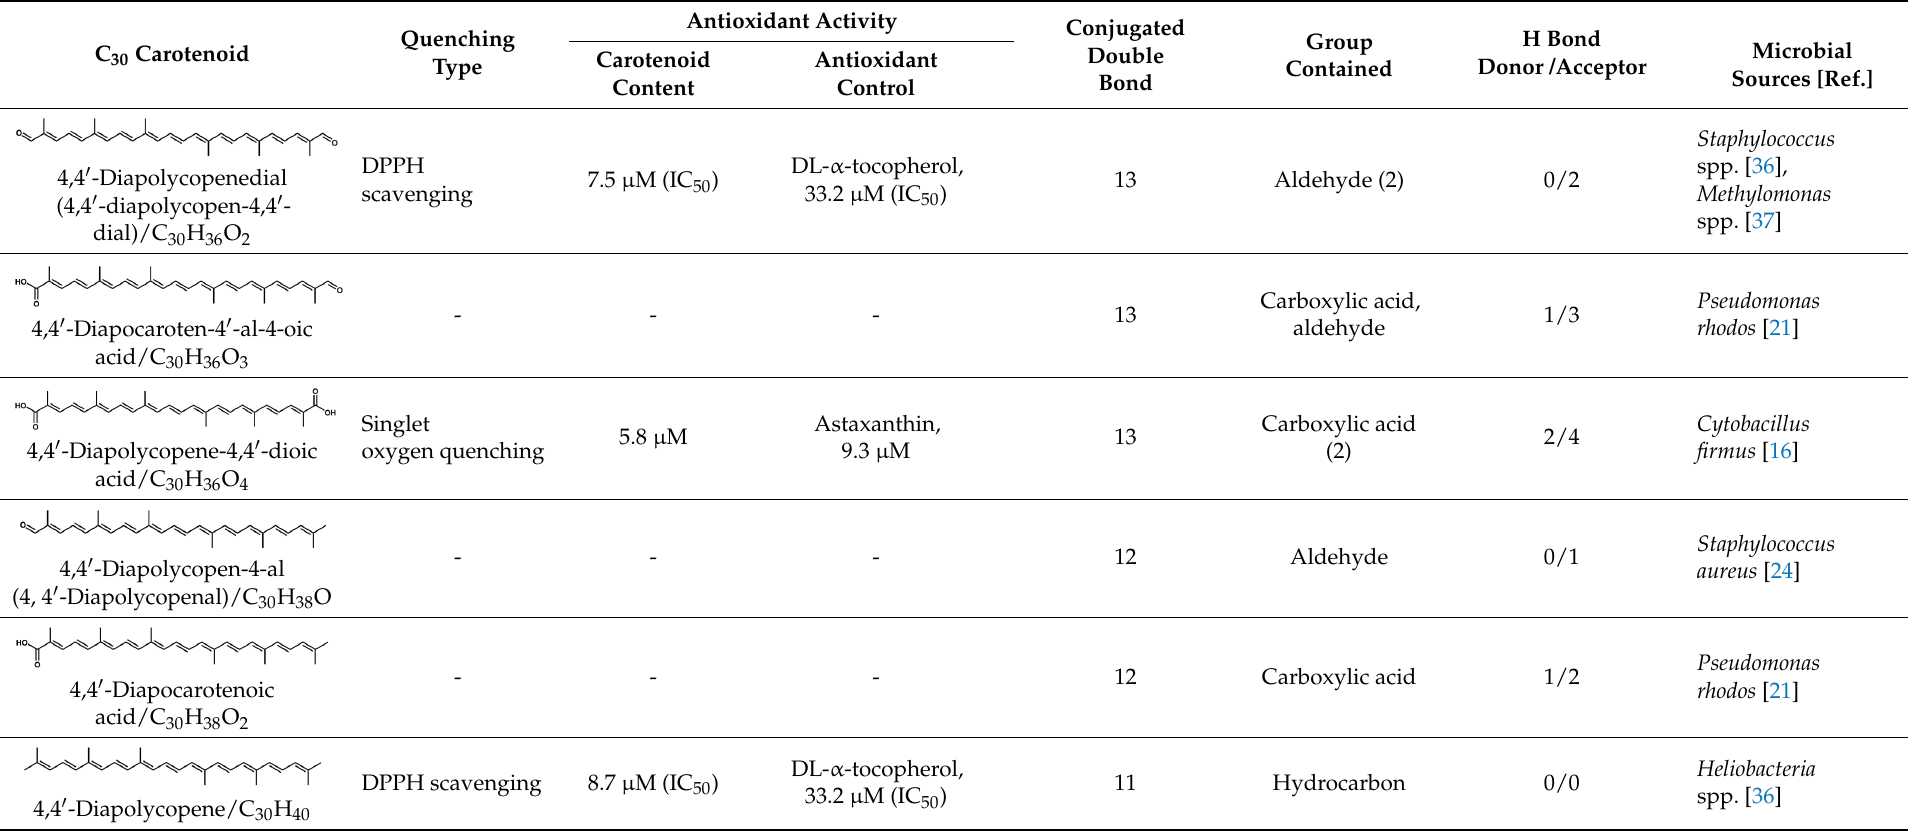
Table 1. Antioxidant contents and capacities of C 30 carotenoids.